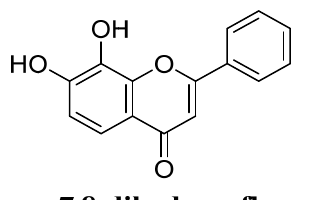
against several neurological diseases or disorders, i.e., stroke, depression and Parkinson’s significant oral bioavailability and found to cross the brain–blood-barrier (BBB). Hence, this flavone found to be a superior phytoconstituent for treating depression disorder as it acts on nitric oxide signalling pathway and activated TrkB receptors (tropomyosin receptor kinase B), also [42,43].